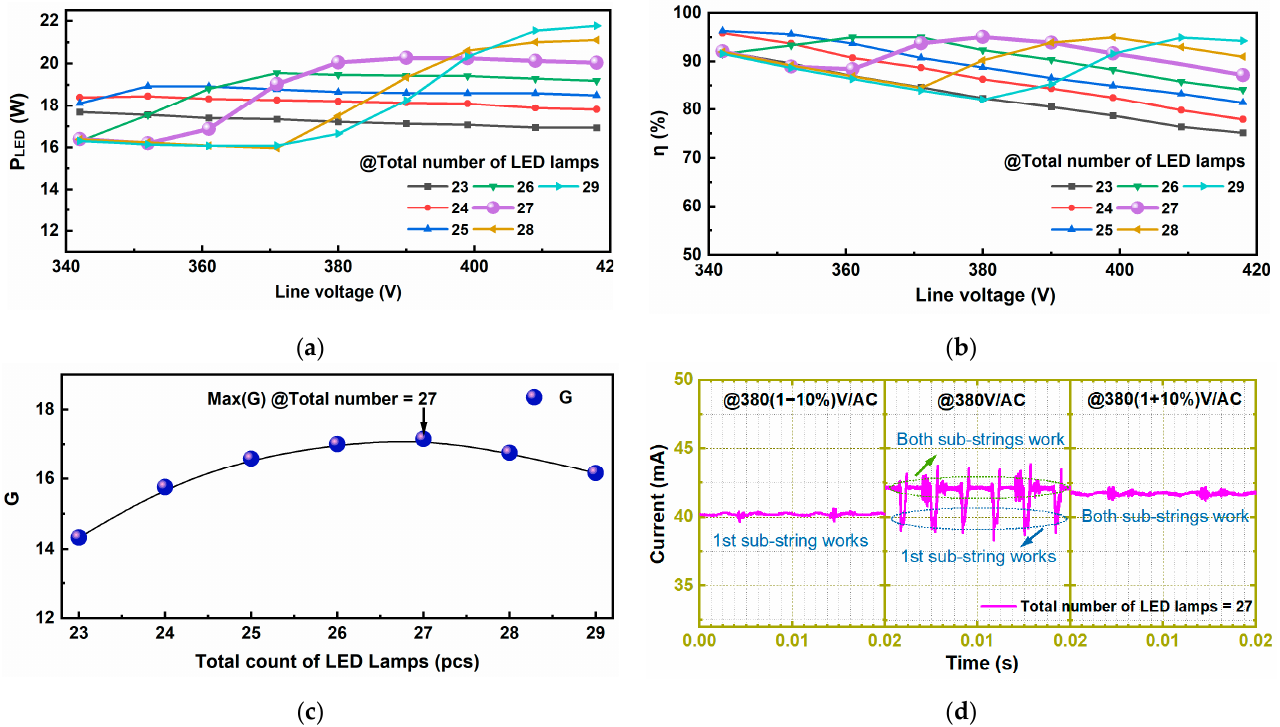
Figure 7. ( a ) LED power, ( b ) driving efficiency, ( c ) optimization goal G , and ( d ) driving current in double-string GaN LED driving experiment.